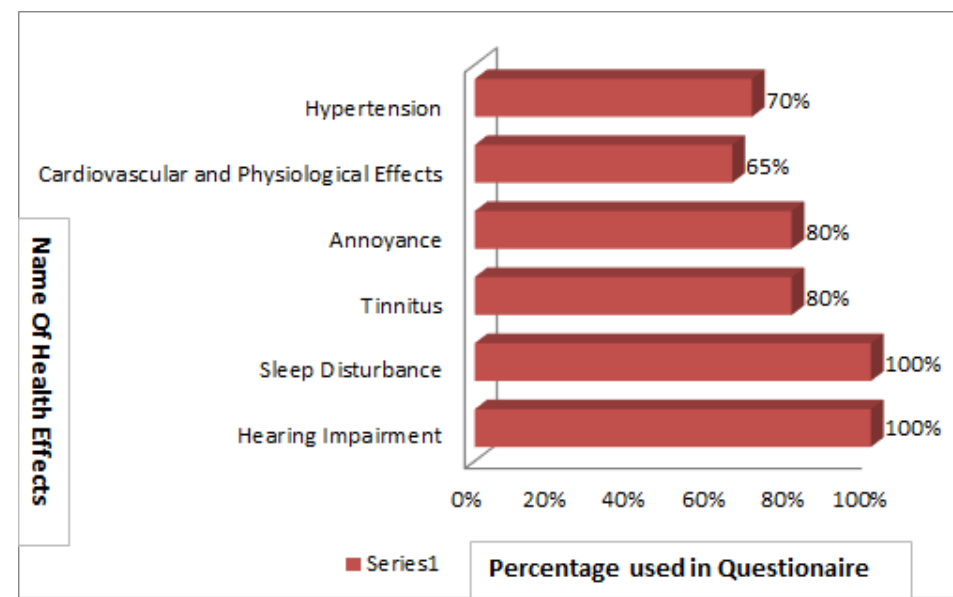
14 Figure 12. Identification and comparison of health hazards for noisy and less noisy intersections.